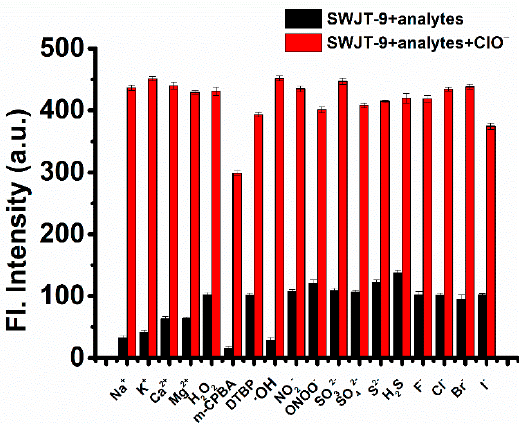
Figure 2. Fluorescence response of probe SWJT-9 (10.0 μ M) toward ClO – (2.0 mM) and various analytes (2.0 mM) in the EtOH/PBS buffer solution (9:1, v / v , pH 7.4). Black bar: SWJT-9 + various analytes; red bar: SWJT-9 + various analytes + ClO – . λ em = 667 nm.